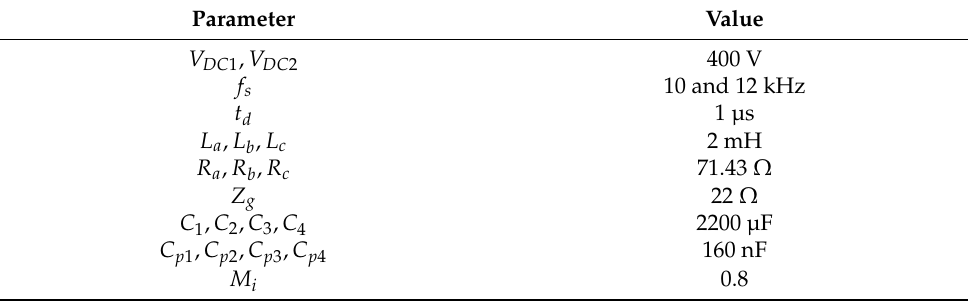
Table 3. Simulation and experimental